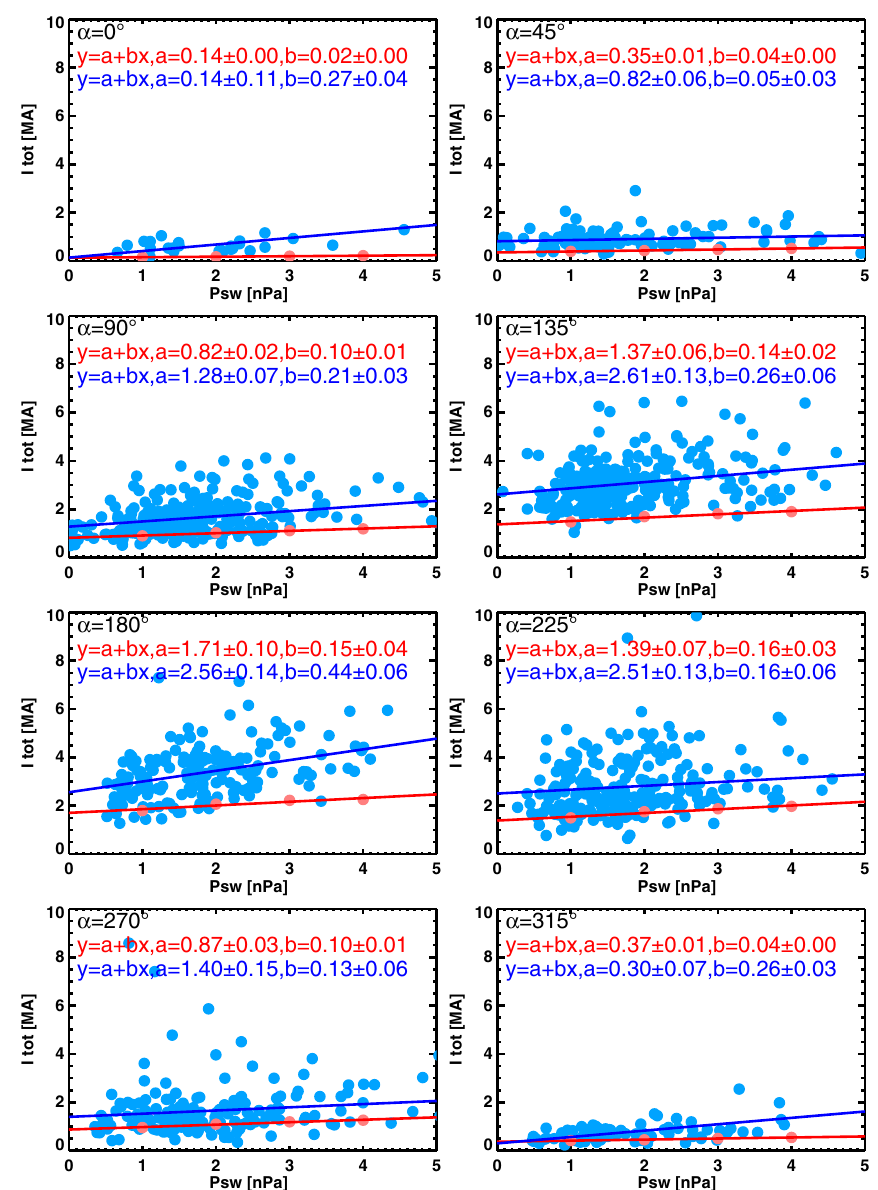
Fig. 8. Dependence of total current on solar wind ram pressure, p sw , and IMF clock angle, α , for the Iridium observations (blue dots) and the BATS-R-US plus RCM simulations (red dots). The lines of the respective color represent the linear least-squares fit functions noted at the top of each